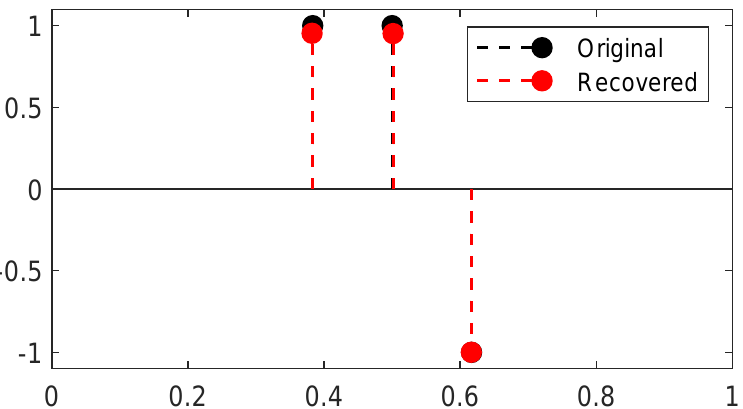
Figure 4. Reconstruction by Sliding Frank-Wolfe for a 1D Fourier operator, with the same settings ( y , noise realisations, λ = 1) as the former section. All ground-truth spikes are reconstructed, no spurious spike is detected.